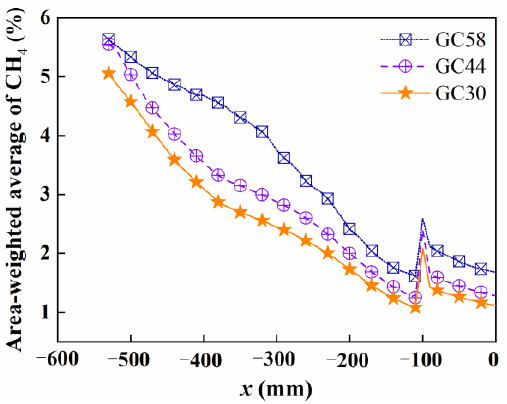
Figure 6. The area-weighted average of methane mass fraction at different section within hood.